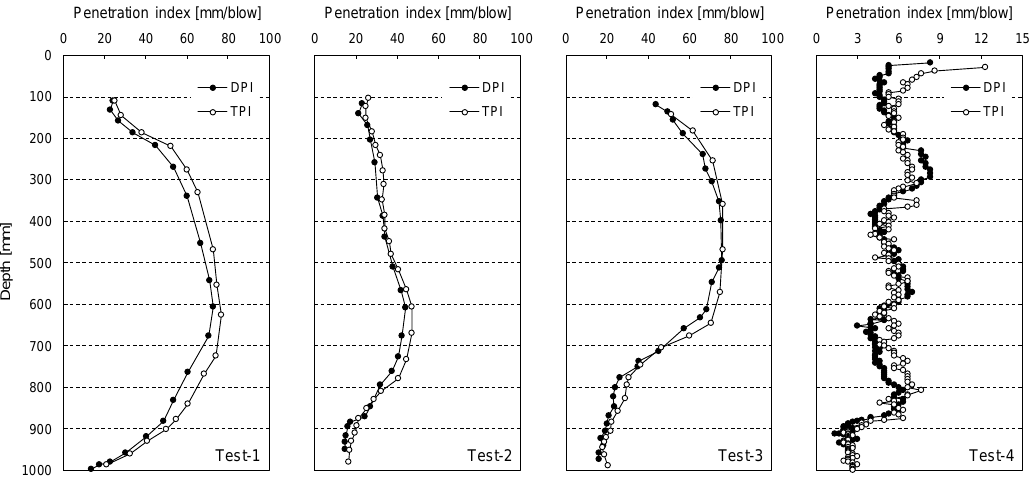
Figure 9. Penetration index profiles measured using the dynamic cone penetrometer (DCP) and TDCP at Test-1 to Test-4.